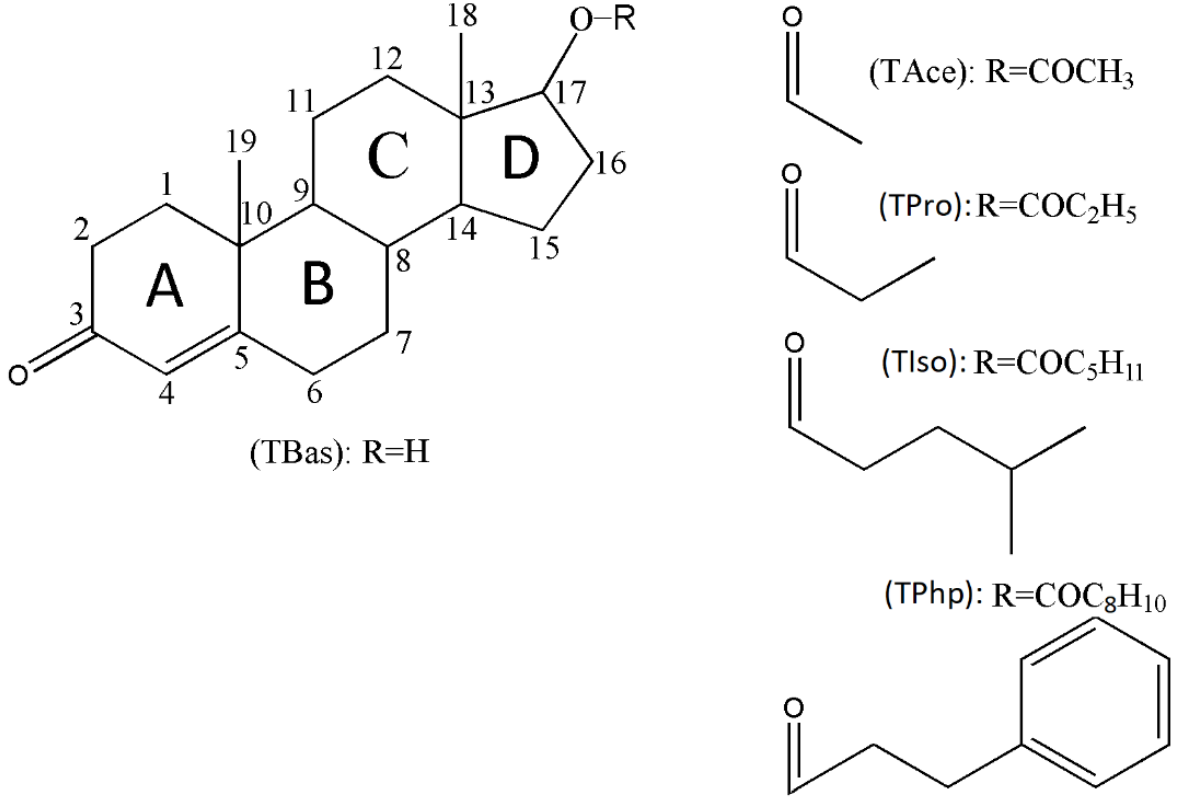
Figure 1. Chemical structures of 17β -hydroxyandrost-4-en-3-one (testosterone) displaying the steroid backbone labelling system and other studied testosterone-based steroids.